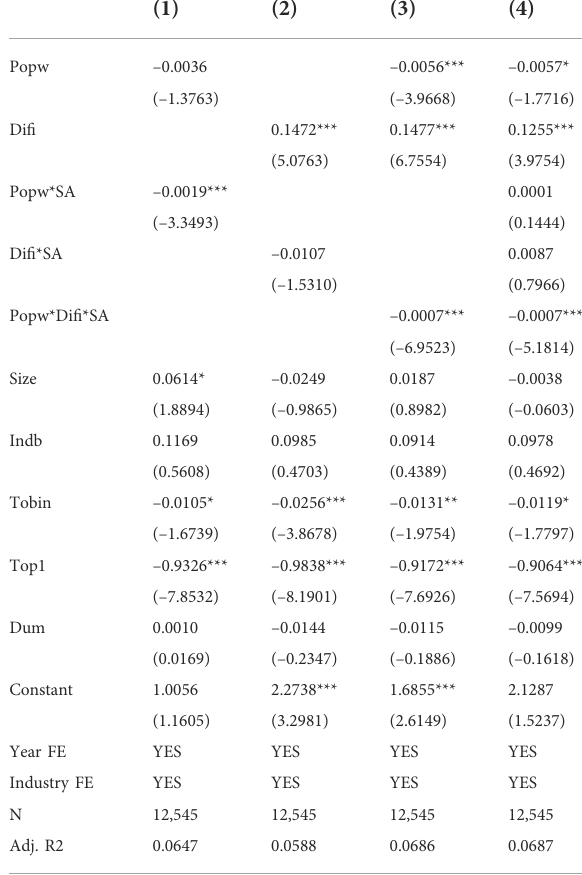
TABLE 5 Moderation effect of fi nancing